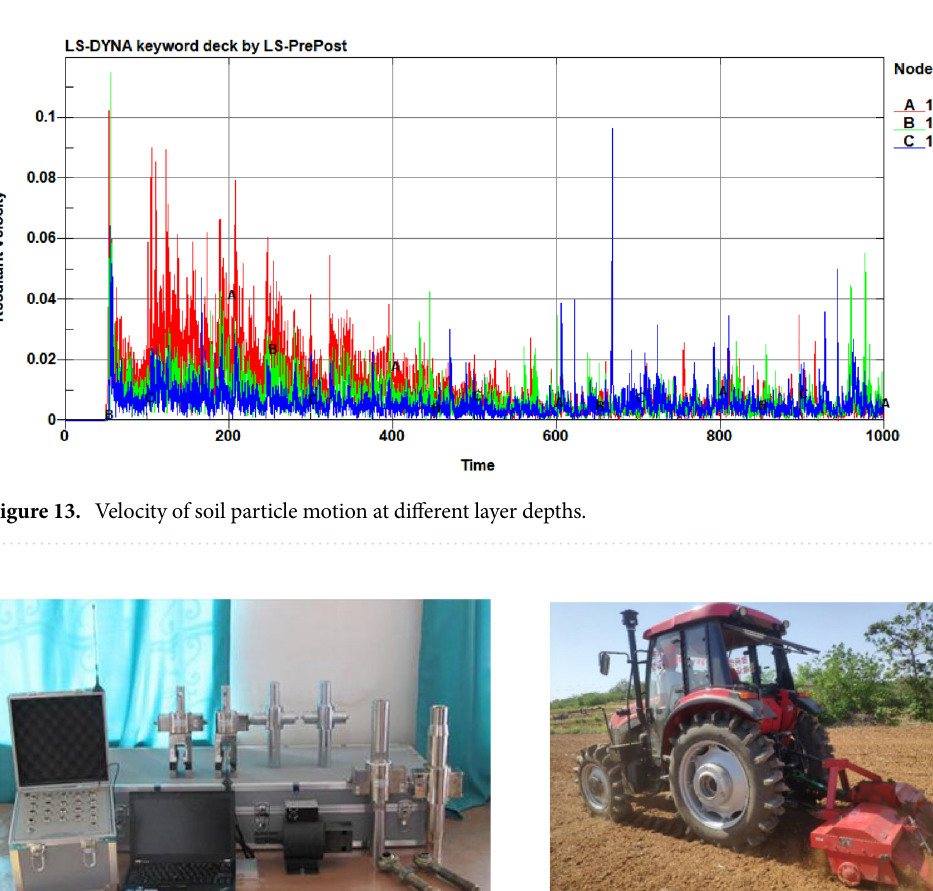
Figure 12. Internal energy change of single rotary blade during cutting.